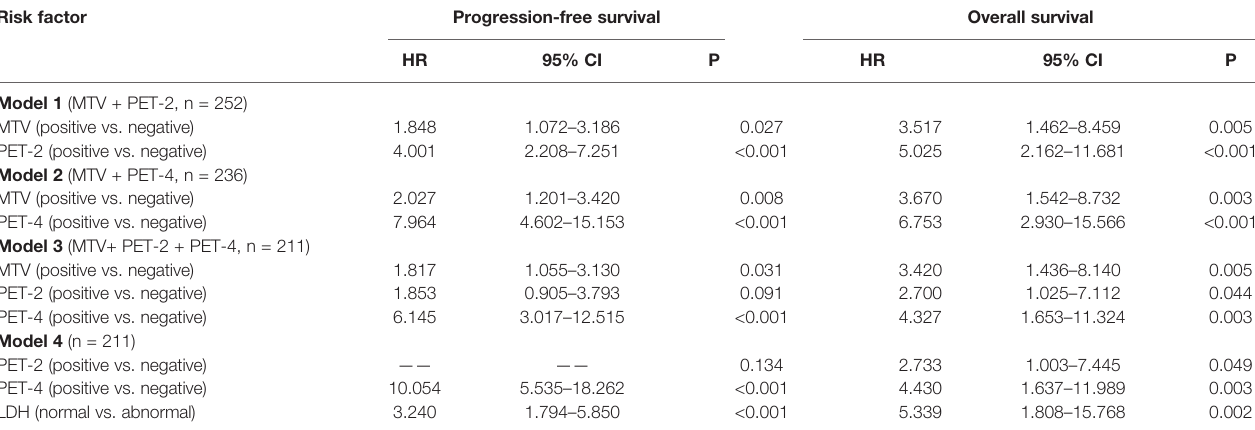
TABLE 5 | Multivariate analysis for survival and disease progression (PET response interpretation: Peking criteria). Risk factor Progression-free survival Overall survival HR 95% CI P HR 95% CI